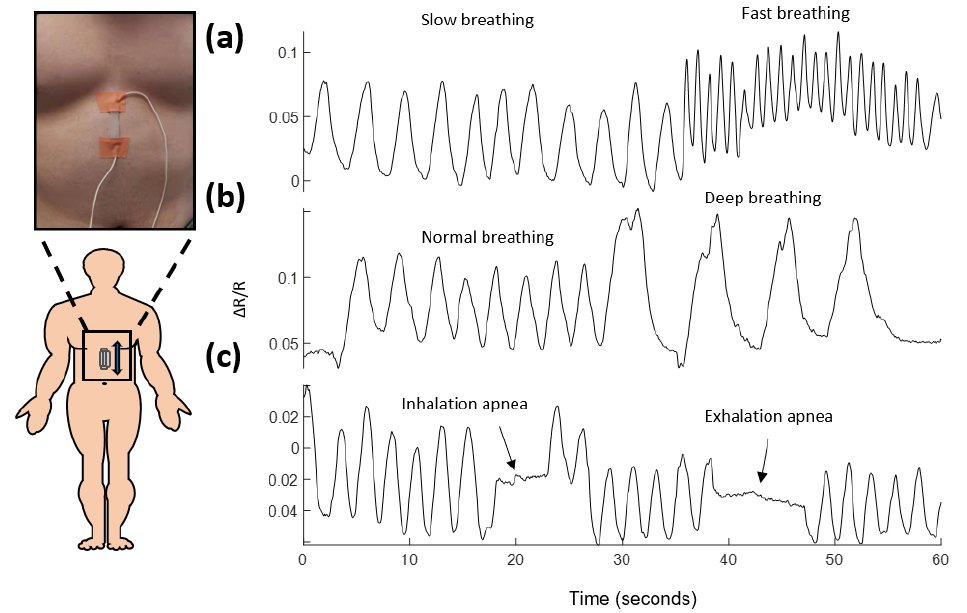
Figure 7. Relative change in resistance in response to different types of breathing events. ( a ): Breath- ing rate monitoring. ( b ): Breathing volume monitoring. ( c ): Apnea